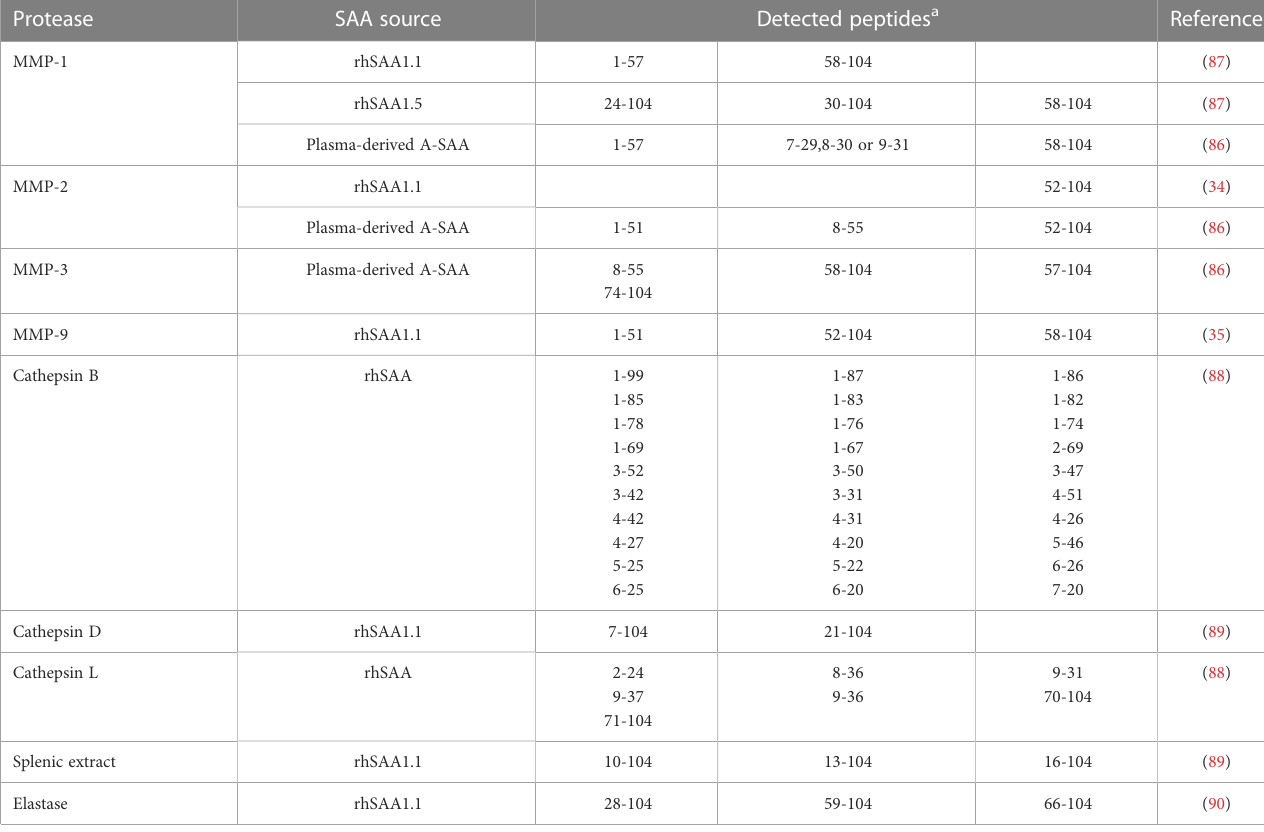
TABLE 2 Cleavage products of commercial and naturally occurring A-SAA variants following proteolytic cleavage by different proteases. Protease